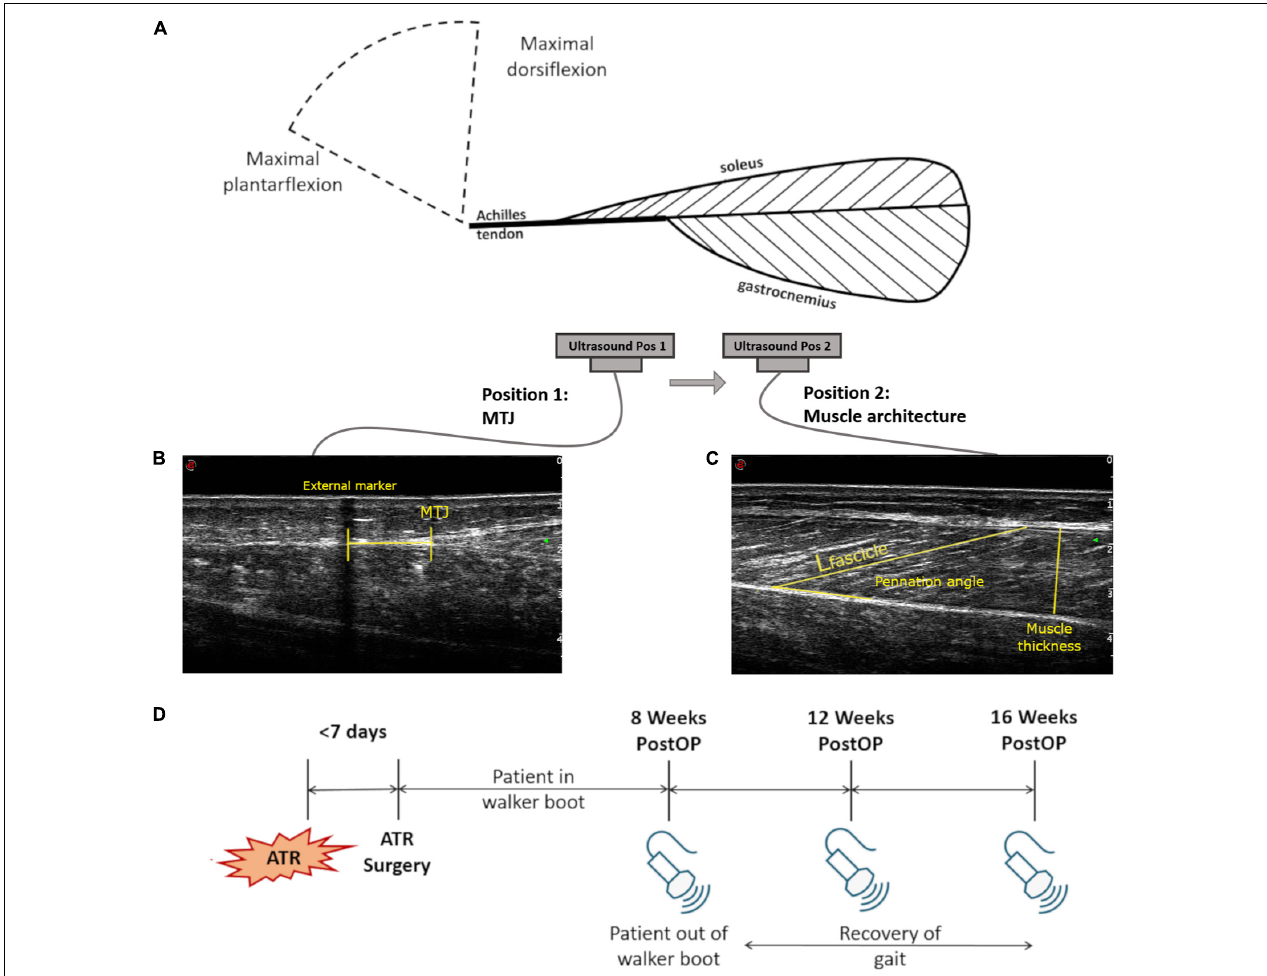
FIGURE 1 | Measurement setup and study description. (A) Schematic of the measurement setup for the ultrasound capture, showing the muscle-tendon unit (MTU) tissues and the two positions of the ankle and the two relative positions of the single ultrasound probe. Two separate ultrasound images were taken at both maximal plantarflexion and dorsiflexion: (B) Sample ultrasound image locating the musculotendinous junction (MTJ) displacement of the Achilles tendon to the medial gastrocnemius with respect to an external skin marker. (C) Sample ultrasound image of medial gastrocnemius architecture measures at the midbelly of the calf, illustrating how fascicle length ( L fascicle ), muscle thickness, and pennation angle were assessed. (D) Timeline of the three measurement sessions with relation to the time of ATR injury and surgical treatment.